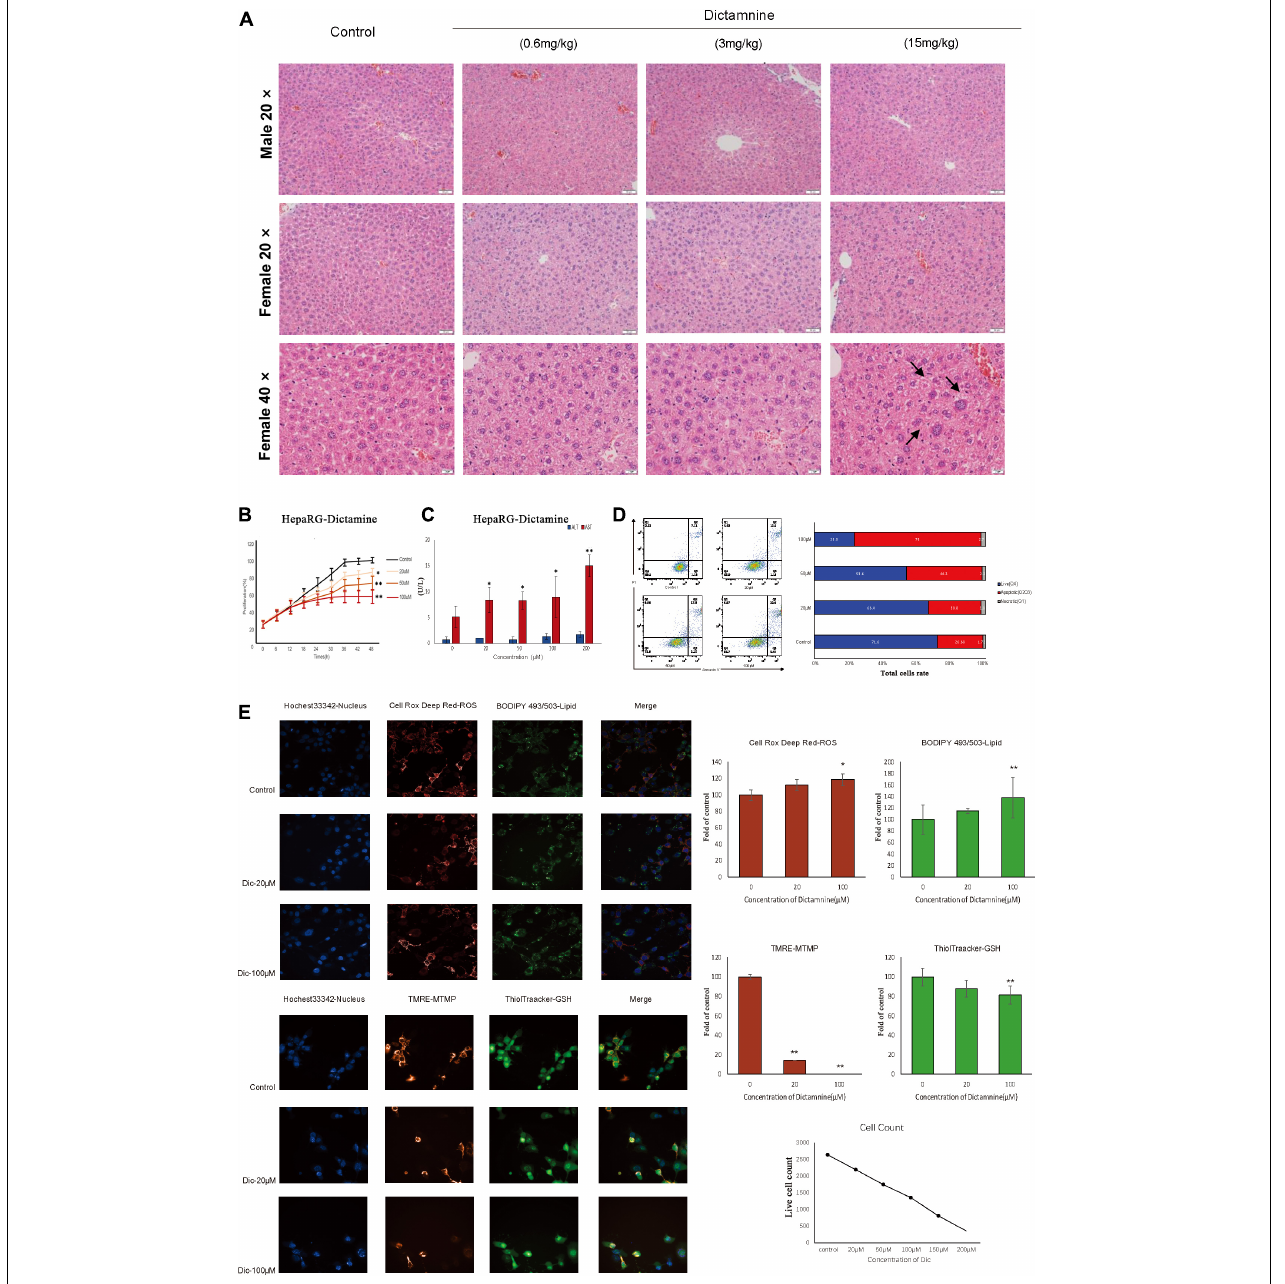
FIGURE 1 | In vivo and in vitro dictamnine-induced hepatotoxicity. (A) Histological examination of livers of mice treated with dictamnine (H&E stained, 20, 40 × magnification). (B) Apoptosis assay of HepaRG cells treated with multiple concentrations (20, 50, and 100 µ M) of dictamnine. (C) Determination of ALT and AST biomarkers activities in dictamnine treated HepaRG cell lines. (D) High-content screening of HepaRG cells exposed to dictamnine (20 µ M, 100 µ M). ∗ P < 0.05 and ∗∗ P < 0.01, vs. Con). (E) Fluorescence of Hoechst 33342 (to stain nuclei; blue), Cell Deep Red (to reactive oxygen species production; deep red) and BODIPY493/503 (to stain neutral lipids; green); or fluorescence of Hoechst 33342 (to stain nuclei; blue), TMRE (to detect changes in mitochondrial membrane potential; red) and ThiolTracker (to stain glutathione; green).